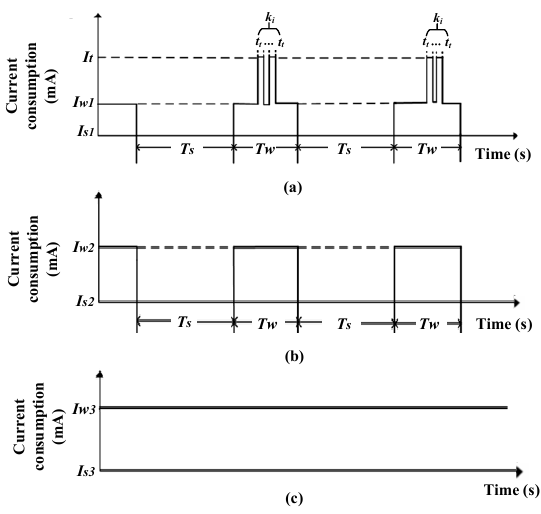
Figure 5. Working sequence diagram for ( a ) WCU, ( b ) DAT, and ( c ) EFS.